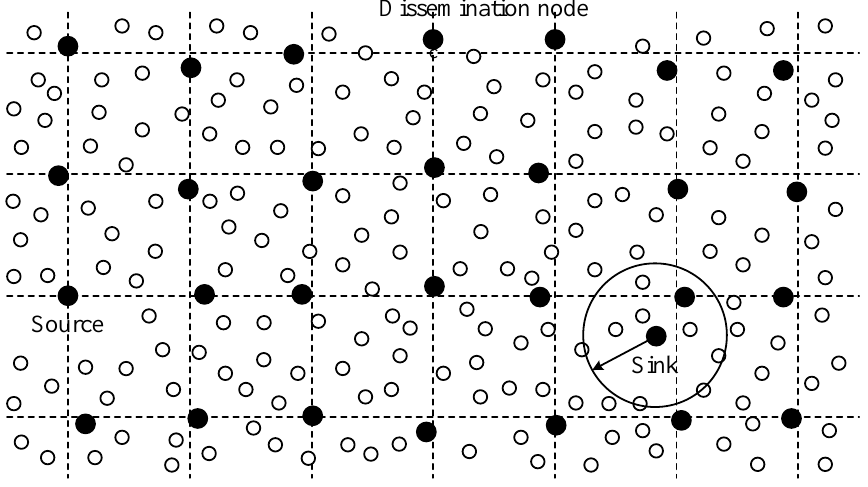
Figure 10. The Grid-based Topology in